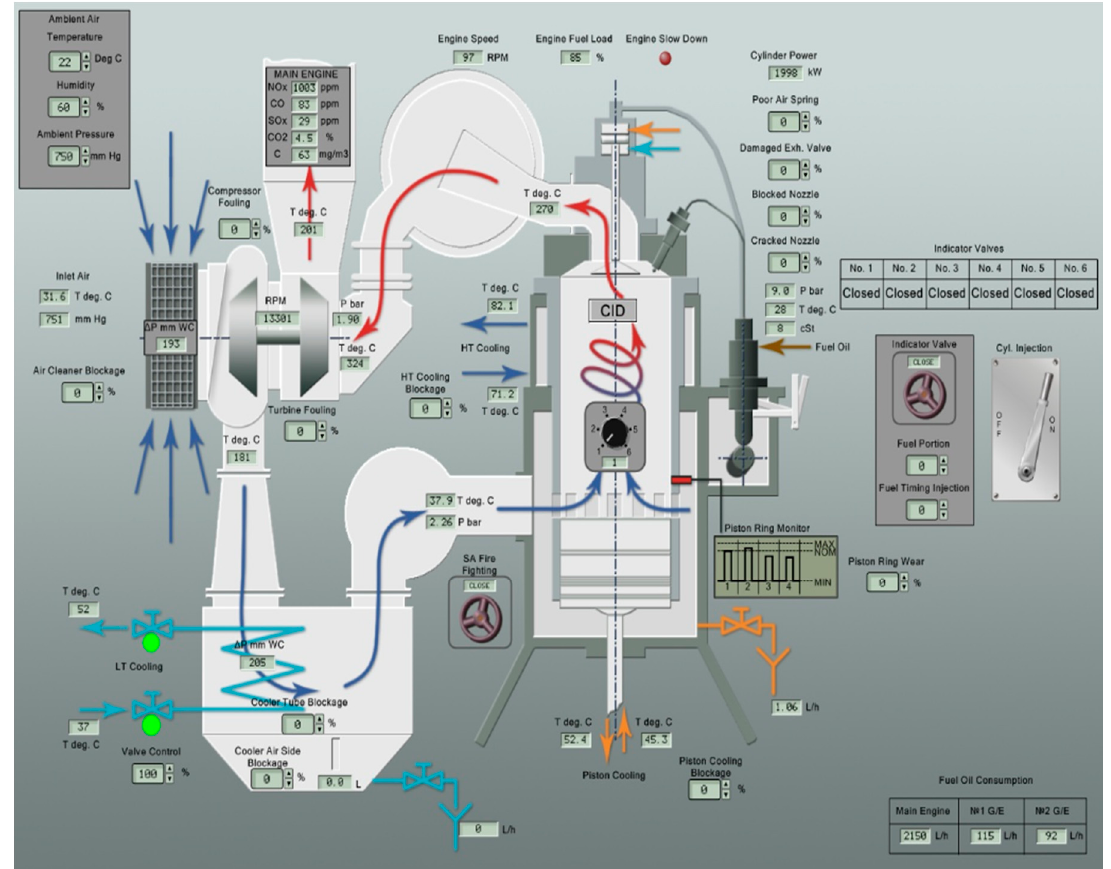
Figure 3. The interface of the main engine (cylinder) on Wärtsilä-Transas simulator [22].